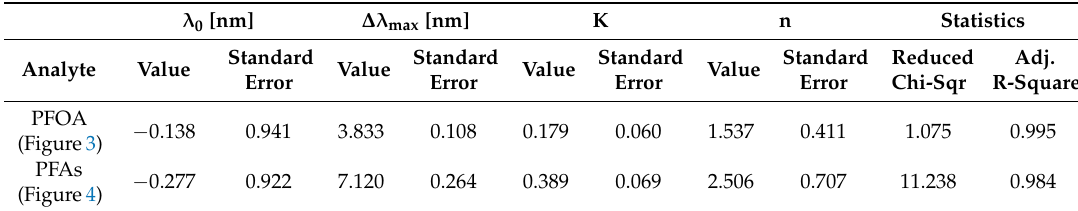
Table 1. Hill parameters (SPR-POF-MIP sensor).